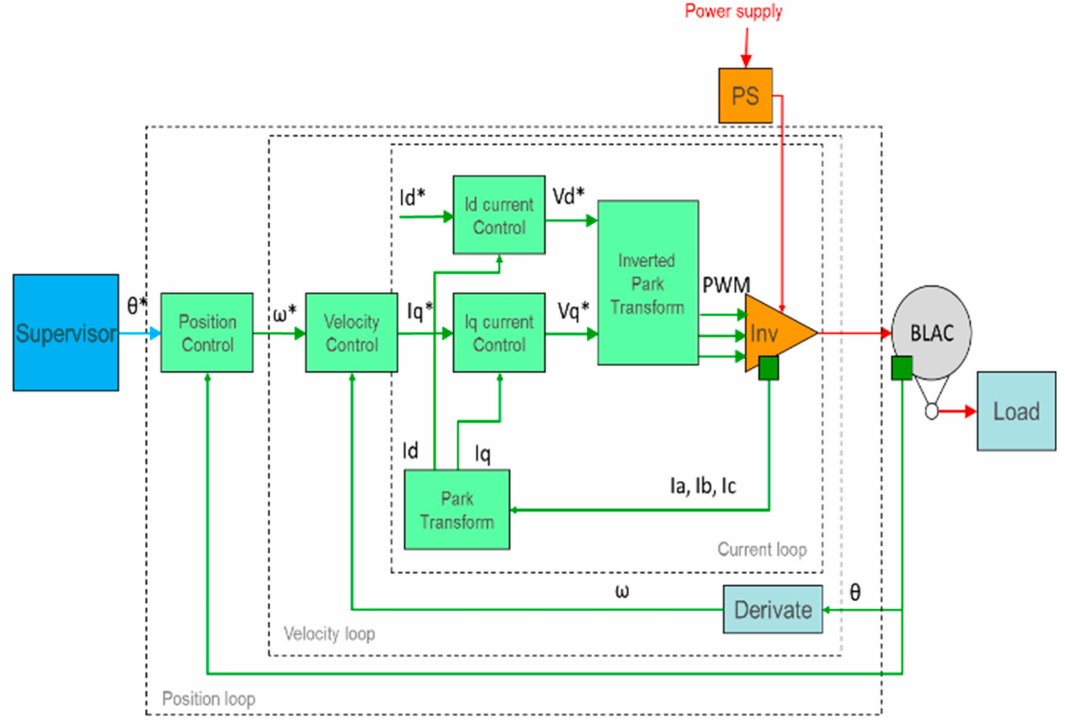
Figure 9. Position control of each BLAC motor (* = set